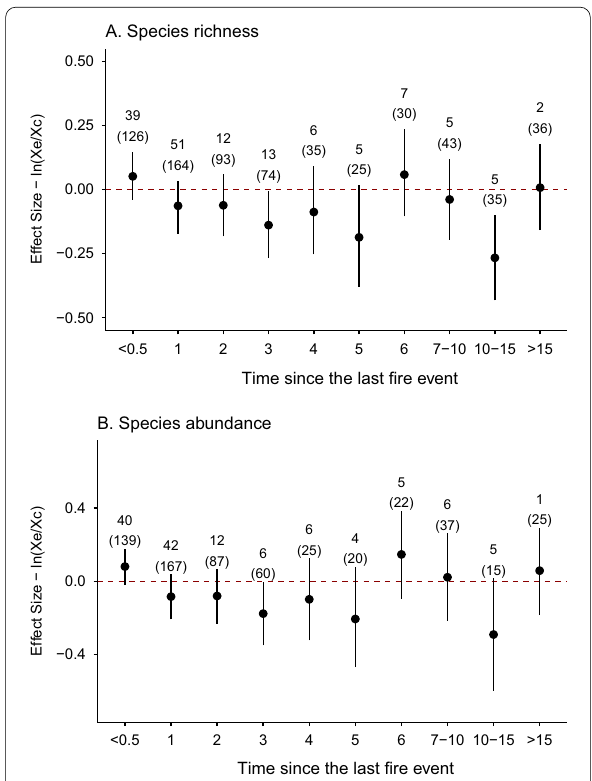
Fig. 5 Effect of fire regime—history—on the richness ( A ) and abundance ( B ) of species. The length of the lines represents the 95% confidence intervals. The numbers above dots represent the numbers of studies, and within parenthesis, the number of study pseudo‑replicas pooled to estimate the effect sizes